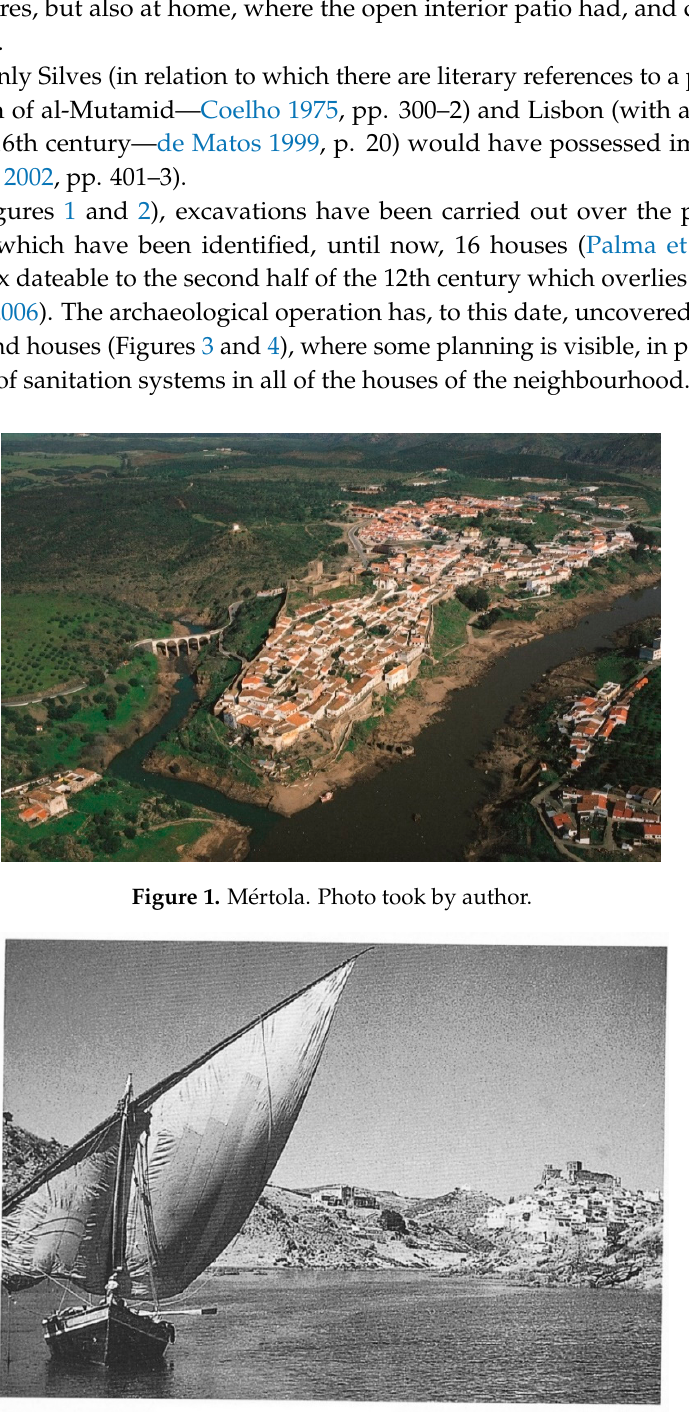
Figure 2. Mértola (c. 1930). Photo owned by the author.